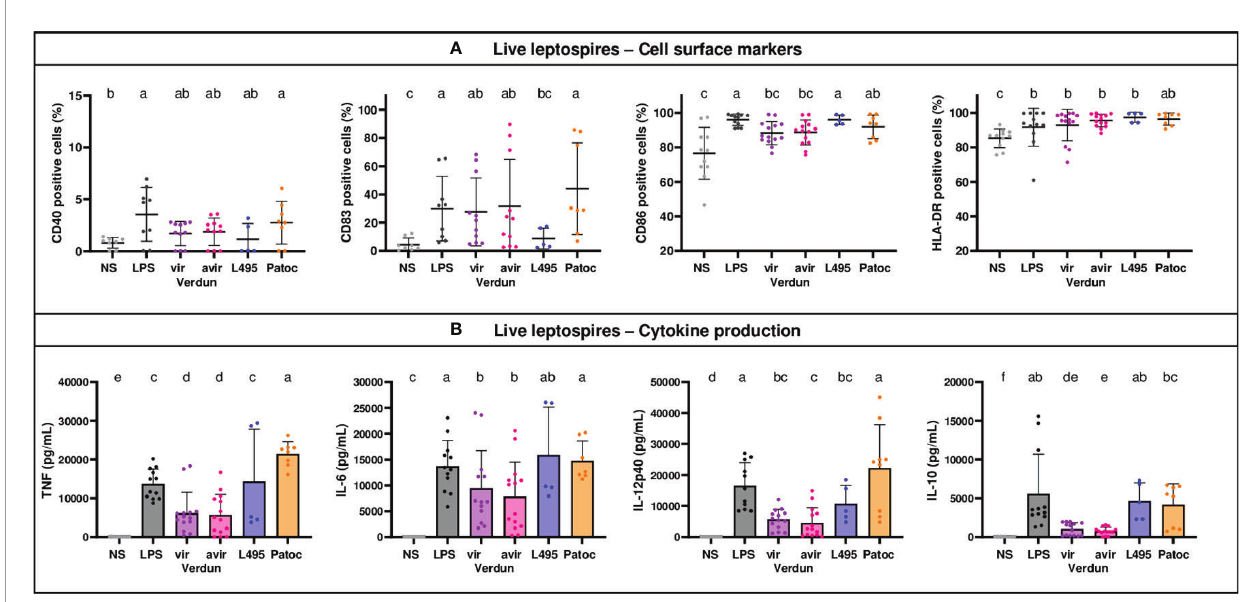
FIGURE 4 | Human MO-DCs exposed to leptospires express more cell surface markers and produce more cytokines. Day 8 Human MO-DCs were stimulated with Icterohaemorrhagiae Verdun vir, Verdun avir, Manilae L495 and Patoc leptospires at a Multiplicity of Infection (MOI) of 100 bacteria per cell for 24h . E . coli LPS (1 µg/ mL) was used as a positive control for DCs stimulation. After 24h, cells were immunostained for the analysis of the expression of cell surface markers (A) through fl ow cytometry and cytokine concentrations (B) were also quanti fi ed in cell supernatants by ELISA assays. Data were compared to results with non-stimulated cells (NS). A: Dot plot diagrams show the percentage of MO-DCs positive for DC-SIGN, CD83, CD86 staining as well as the percentage of ungated cells positive for HLA- DR staining. (B) Histograms with dot plot show the concentration of pro-in fl ammatory TNF, IL-6, and IL-12 and anti-in fl ammatory IL-10 in cell supernatants. Each dot represents stimulation duplicates or triplicates from independent experiments with two to fi ve blood donors. Mean ± SD is also represented. Conditions that share the same lower-case letters are not signi fi cantly different (p > 0.05). In contrast, conditions that do not share same letter(s) are signi fi cantly